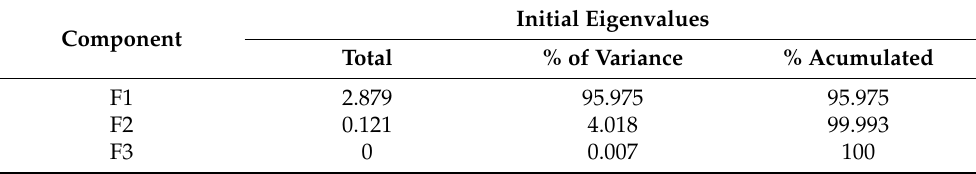
Table 7. First principal component analysis values for inputs: total variance explained.